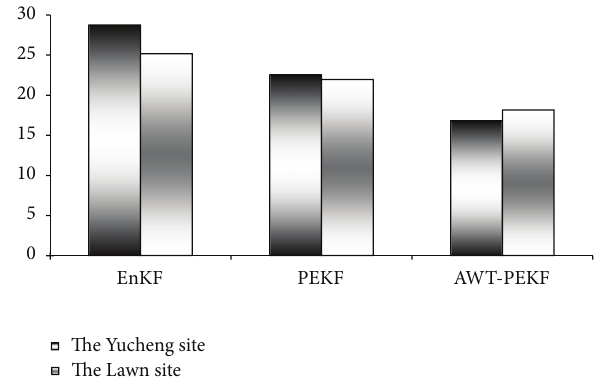
Figure 8: The RMSE histograms of the three methods using the two site